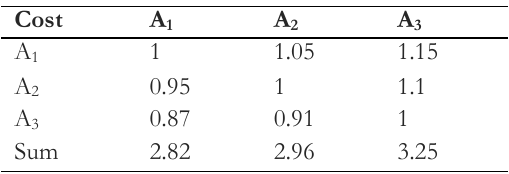
Table 6. Suppliers compared with cost.